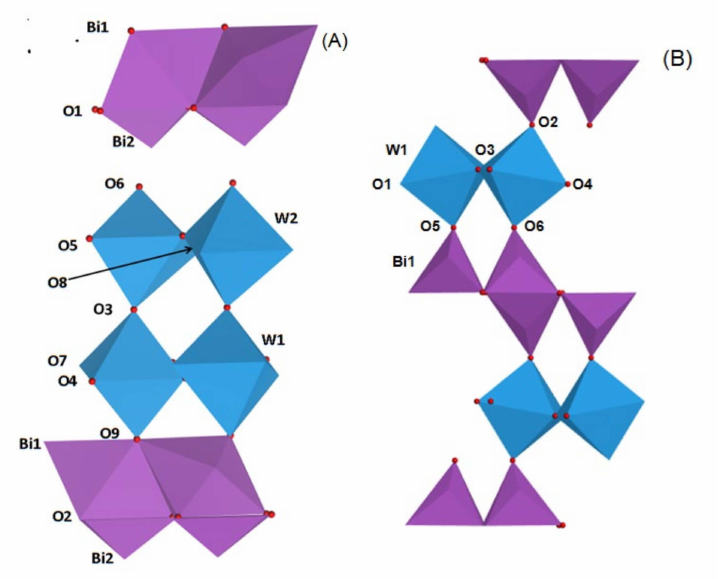
Figure 2. Models of Bi 2 W 2 O 9 ( A ) and Bi 2 WO 6 ( B ) consist of (Bi 2 O 2 ) 2+ and (W 2 O 7 ) 2 − or (WO 4 ) 2 −